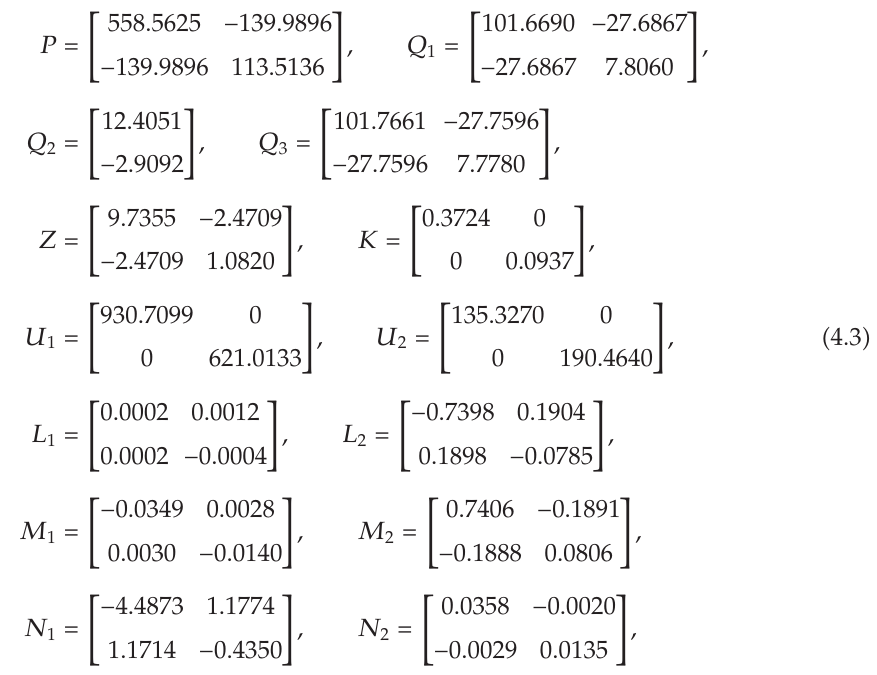
Methods By Corollary 3.4